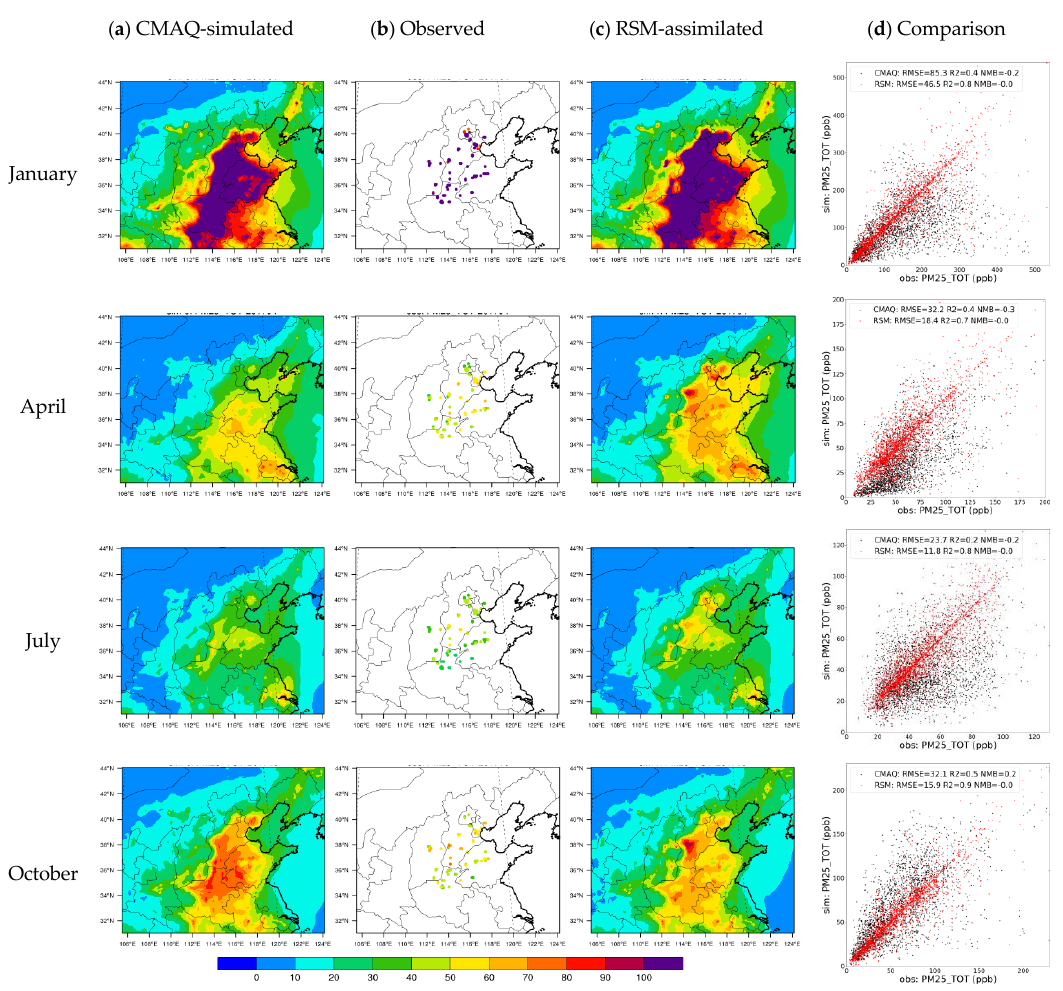
Figure 4. Comparisons of CMAQ-simulated, observed, and RSM-assimilated PM 2.5 concentrations ( a ) CMAQ-simulation; ( b ) Observation; ( c ) RSM-assimilation; ( d ) Comparison between CMAQ-simulation or RSM-assimilation against with obervation (the comparison was done on a monthly basis for each month of comparison; unit, μg·m −3 ).